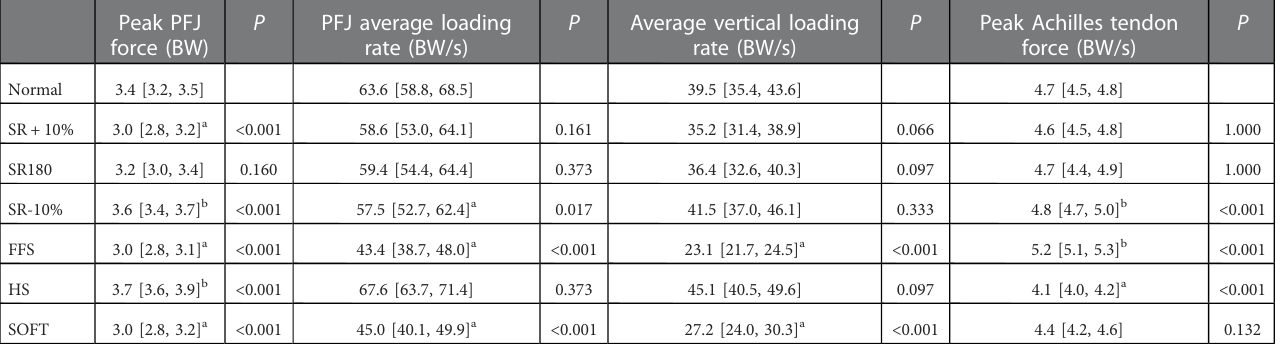
TABLE 2 Comparisons of kinetic variables between Normal and the different gait modi fi cations ( n =68), presented as Mean [95% C.I.]. P -values relate to differences with the Normal condition. Peak PFJ force